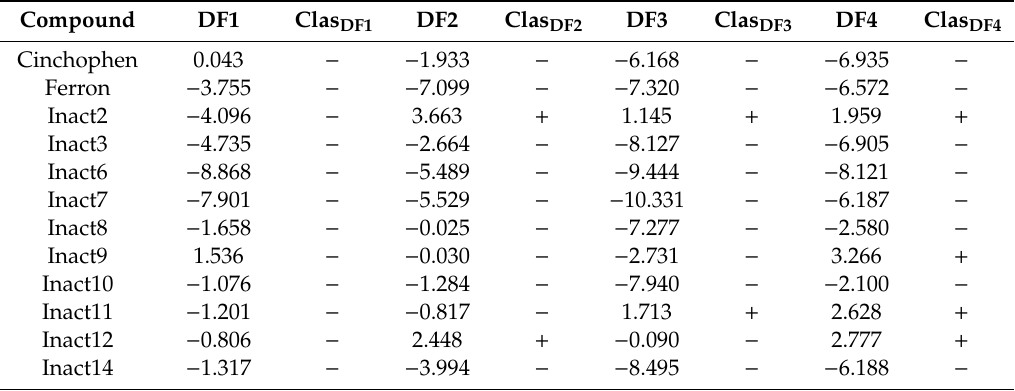
Table 6. Results obtained after combining LDA and PDD for DF1-4. Training group: